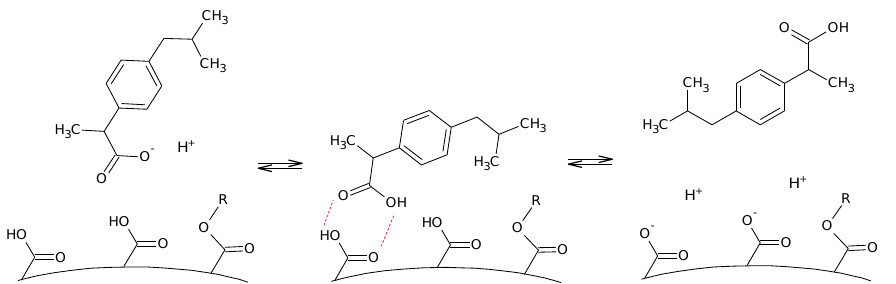
Figure 11. Scheme of possible acid-base balance between an ibuprofen molecule and acid moieties of the